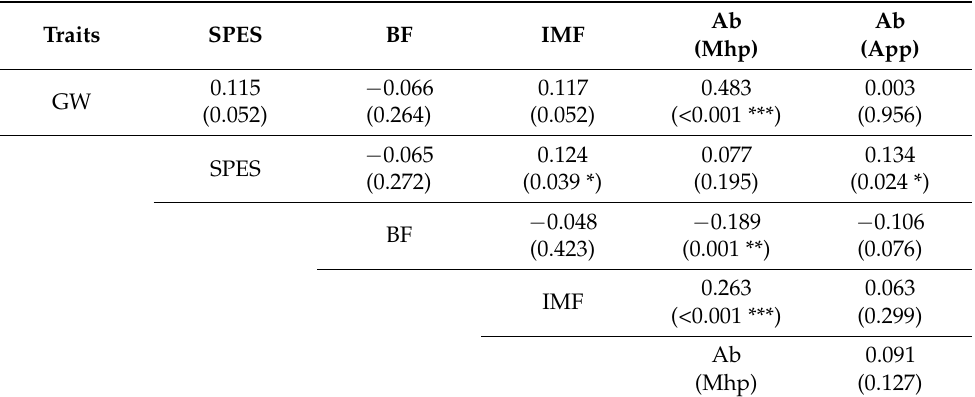
Table 3. Pearson correlation coefficients between the traits